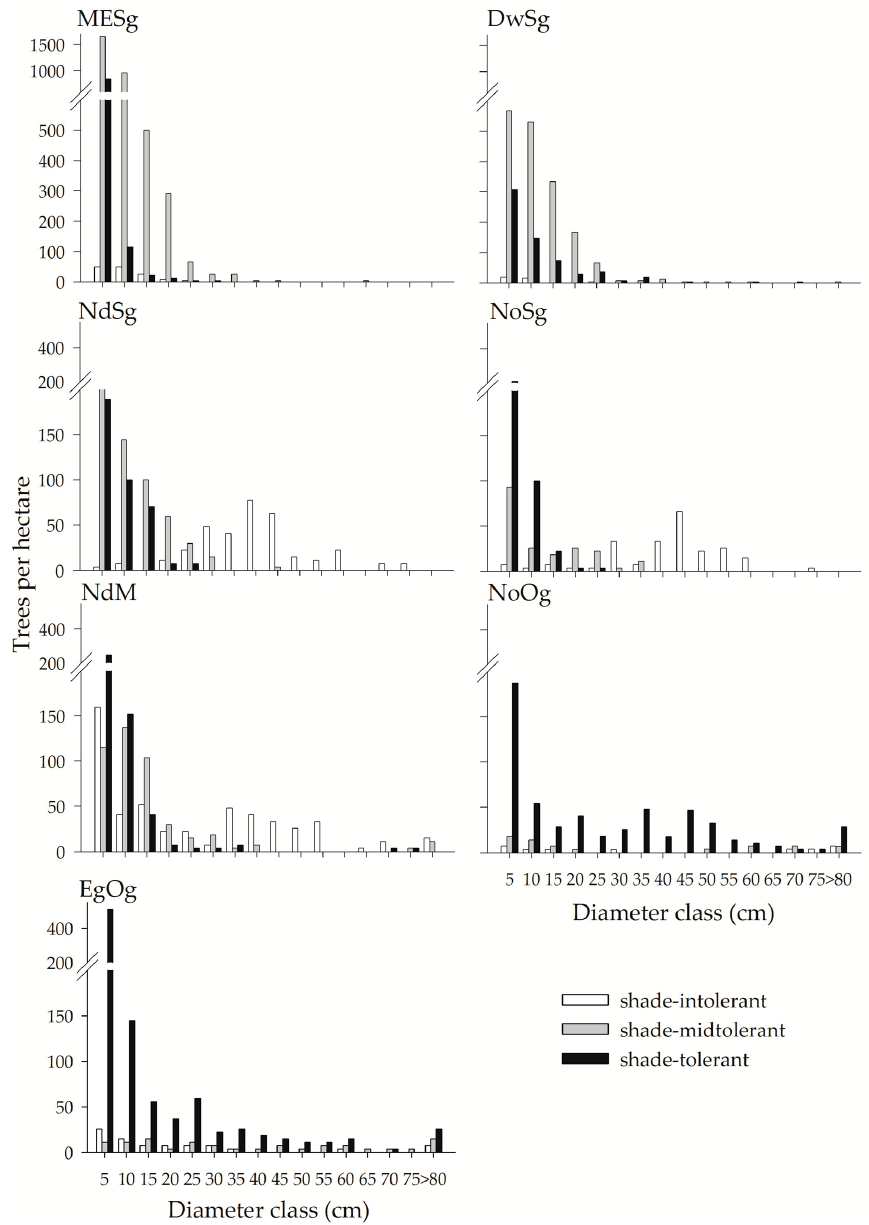
Figure 3. Diameter distribution for each forest studied. See text for meaning of acronyms. Notice that the Y axis of the MESg and DwSg graphs differs from the